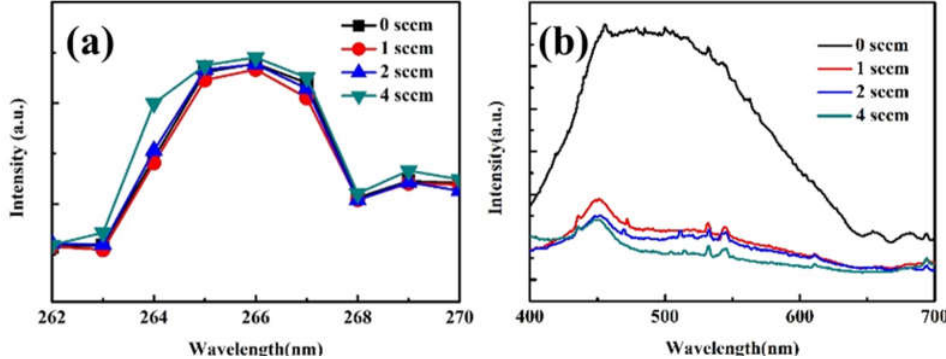
Figure 6. PL spectra of Ga 2 O 3 samples at room temperature. ( a ). UV region; ( b ). Visible region.